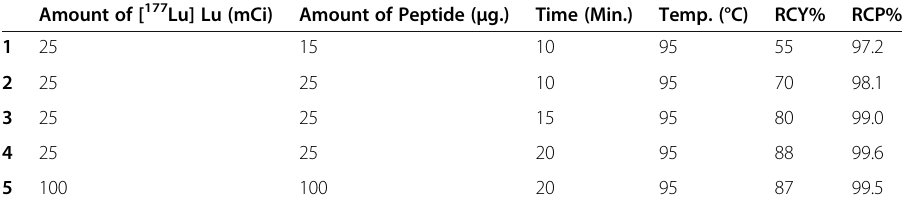
Table 1 Preliminary studies of [ 177 Lu]Lu-FAPI-04 Amount of [ 177 Lu] Lu (mCi) Amount of Peptide ( μ g.)